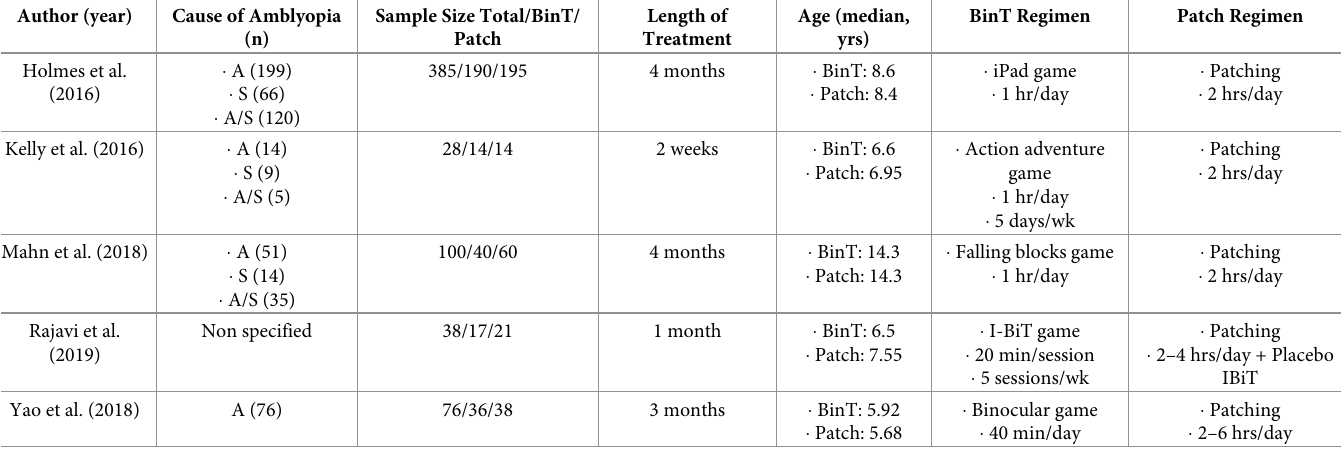
Table 1. Characteristics of the randomized clinical trials included in the